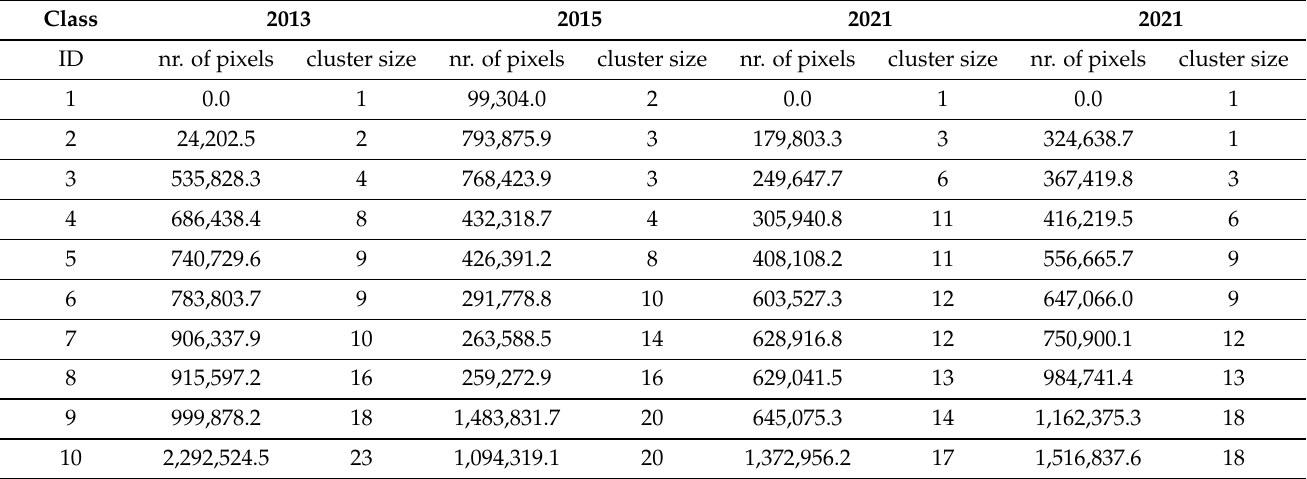
Table 2. Results of the land cover class computations of the Landsat-8 OLI/TIRS satellite images 1 .